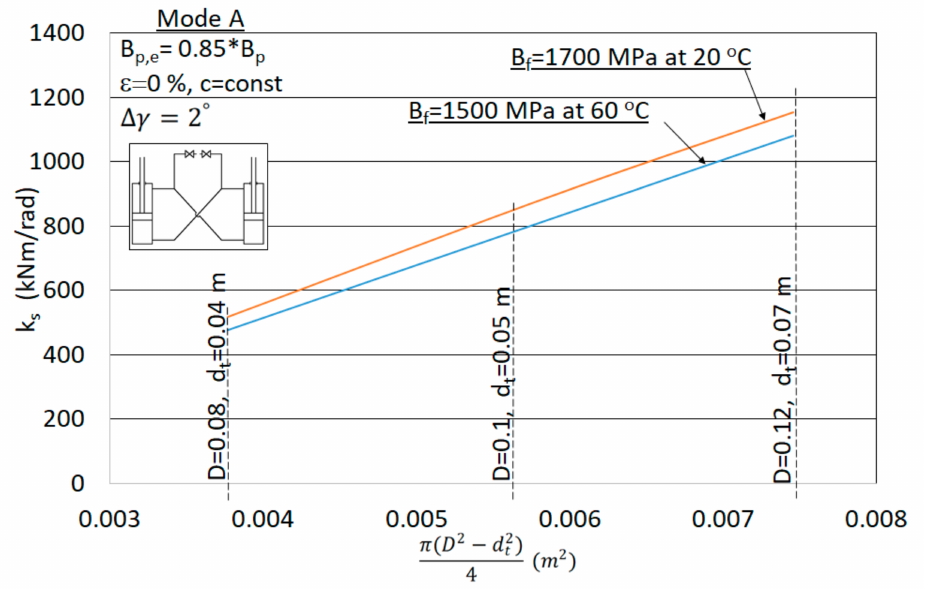
Figure 17. Influence of effective surface area of a hydraulic cylinder at a constant capacitance of the hydraulic system c = const, and bulk modulus of oil B f on equivalent torsional stiffness k s of the steering system.